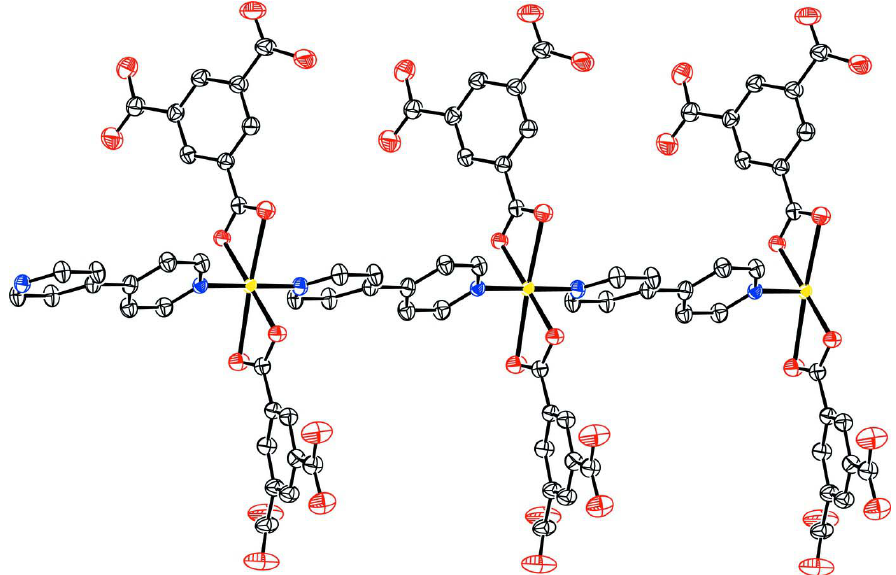
Figure 2 One-dimensional chain structure of (I). H atoms are omitted for clarity. Displacement ellipsoids are drawn at the 50% probability